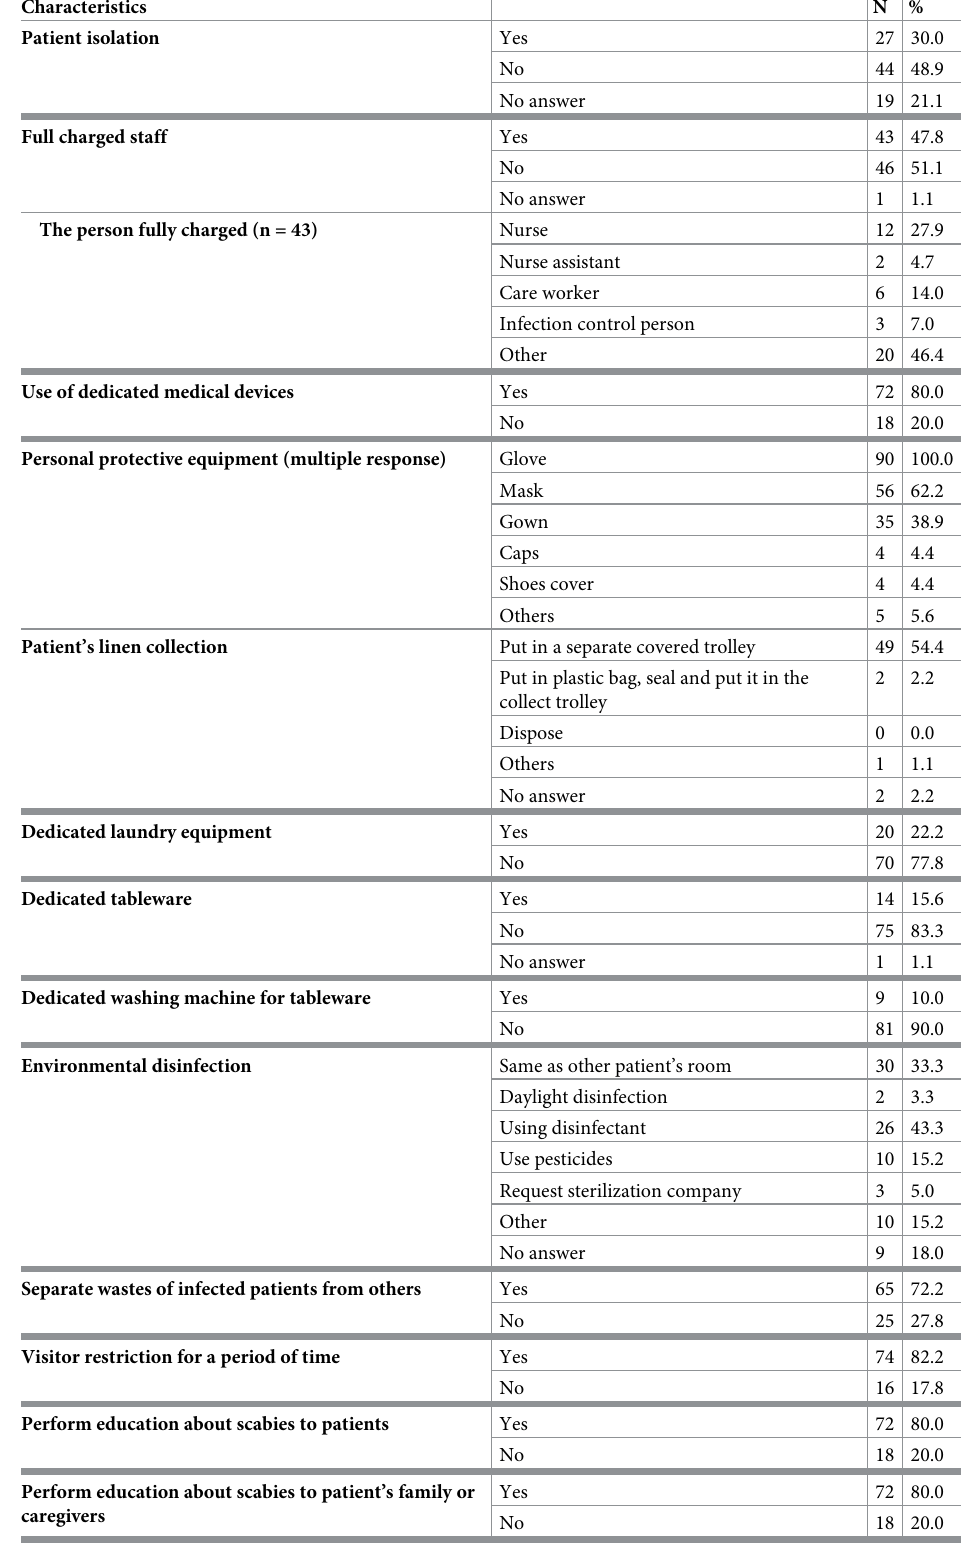
Table 6. Management of patients with scabies (N = 90).